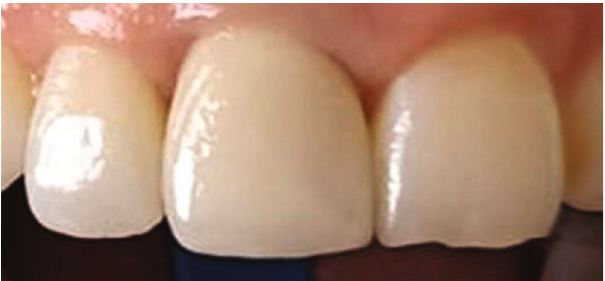
Figure 8: The shape improvement after line angle displacement.